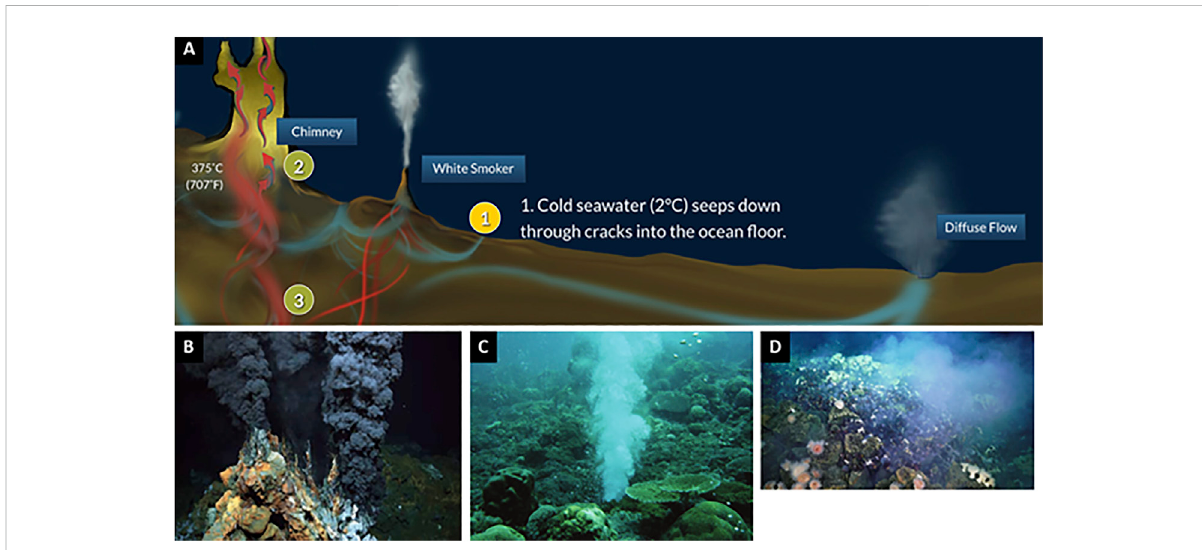
FIGURE 9 Deep sea hydrothermal vents today. (A) Sketch showing high temperature black smoker point sources ( > 350 ° C) on ridge axes, slightly lower temperature white smoker point sources ( < 300 ° C) off ridge axes, and more diffuse, low temperature ( < 100 ° C) sources further away from ridge axes. (sourcedfromtheWoodsHoleOceanographicInstitution). (B) .Blacksmokervent(afterRogersetal.,2015). (C) Whitesmokervent(afterKarlenetal., 2010). (D) Diffuse venting (sourced from